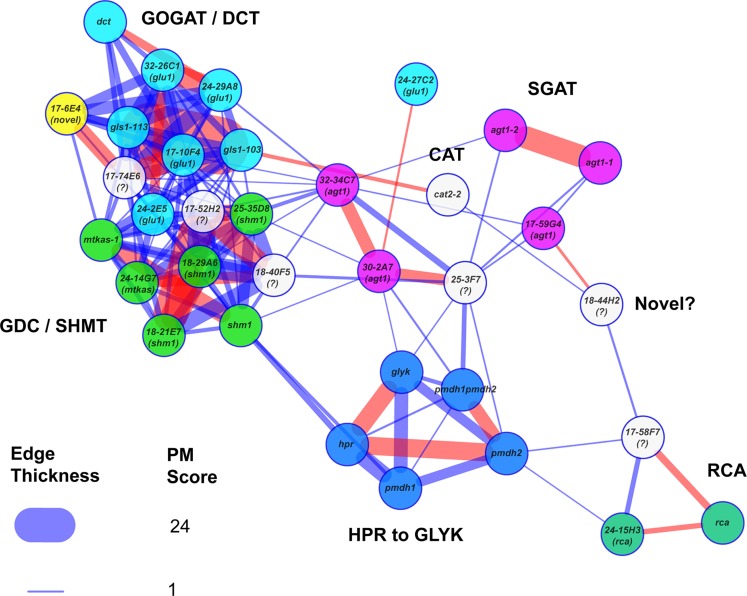
Metabolic phenotype similarity networks reveal functional communities. The known reference and new photorespiratory mutants were selected as both baits and potential prey in a PhenoMeter search to generate a similarity network with a force directed layout. To help reveal clustering within the network, weak matches (edges) with FET2p > 0.007 or R2 < 0.09 were filtered out to leave only moderate to strong matches. To highlight the fact that network structure reflected functional links between the mutants, mutants within various functional categories (labeled) were highlighted in the same color. Stronger similarities between mutant phenotypes (higher PM score) are represented by thicker edges. Edges in red represent the top hit of at least one of the nodes. Mutants marked with a “?” were not included in the set of mutants that were checked for mutations by next generation sequencing. The loose connectivity of 18-44H2 with the rest of the network and the fact that its causative mutation was mapped to a region free of known photorespiratory genes (data not shown) suggests it might be a novel class of photorespiratory mutant. The novel glu1-like mutant (17-6E4), highlighted in yellow, was tightly connected within the GOGAT/DCT neighborhood despite having no consequential mutations in any known photorespiratory genes.